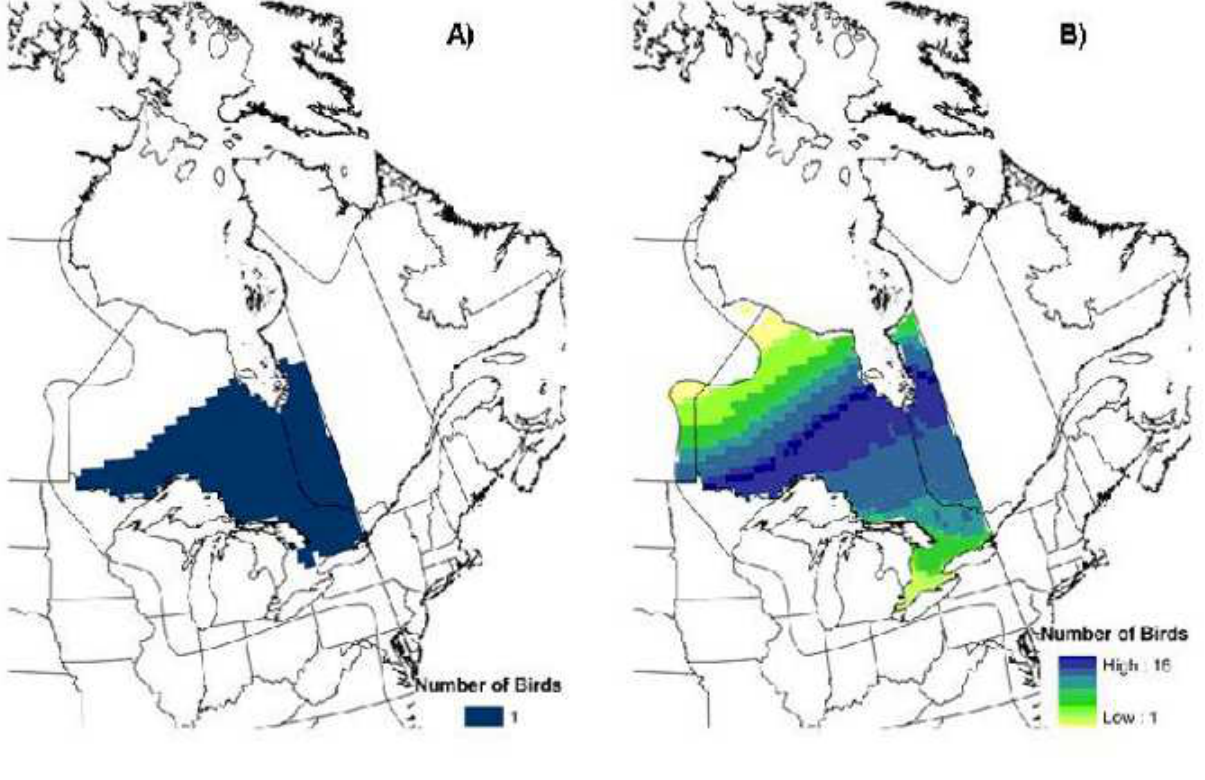
Fig. 4. Probable origins of American Black Ducks ( Anas rubripes ) harvested in the Western breeding/ harvest region during the 2005 hunting season for birds fed in A) agricultural areas ( n = 1) and B) in nonagricultural areas ( n = 20). A likelihood based assignment was used to place individuals to geographic origins on the basis of stable hydrogen isotope values (see Methods). The results displayed represent the sum of assignments across the samples (see